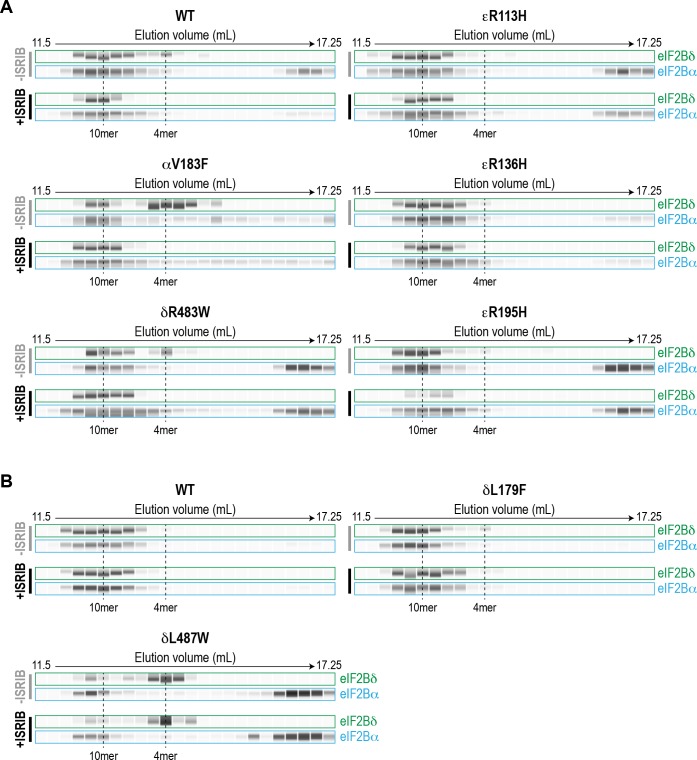
Recombinant eIF2B VWMD mutants have reduced complex stability that is rescued by ISRIB.(A–B) Immunoblotting of eIF2Bδ (representative of the 4mer subcomplex) and eIF2Bα from the SEC experiments in (A) Figure 2E and (B) Figure 3B. Bands shown are simulated representations of the electropherogram signal from the Wes instrument. Dashed lines indicate the positions of 10mer and 4mer based on UV peak profiles (see Figure 2E and Figure 3B).